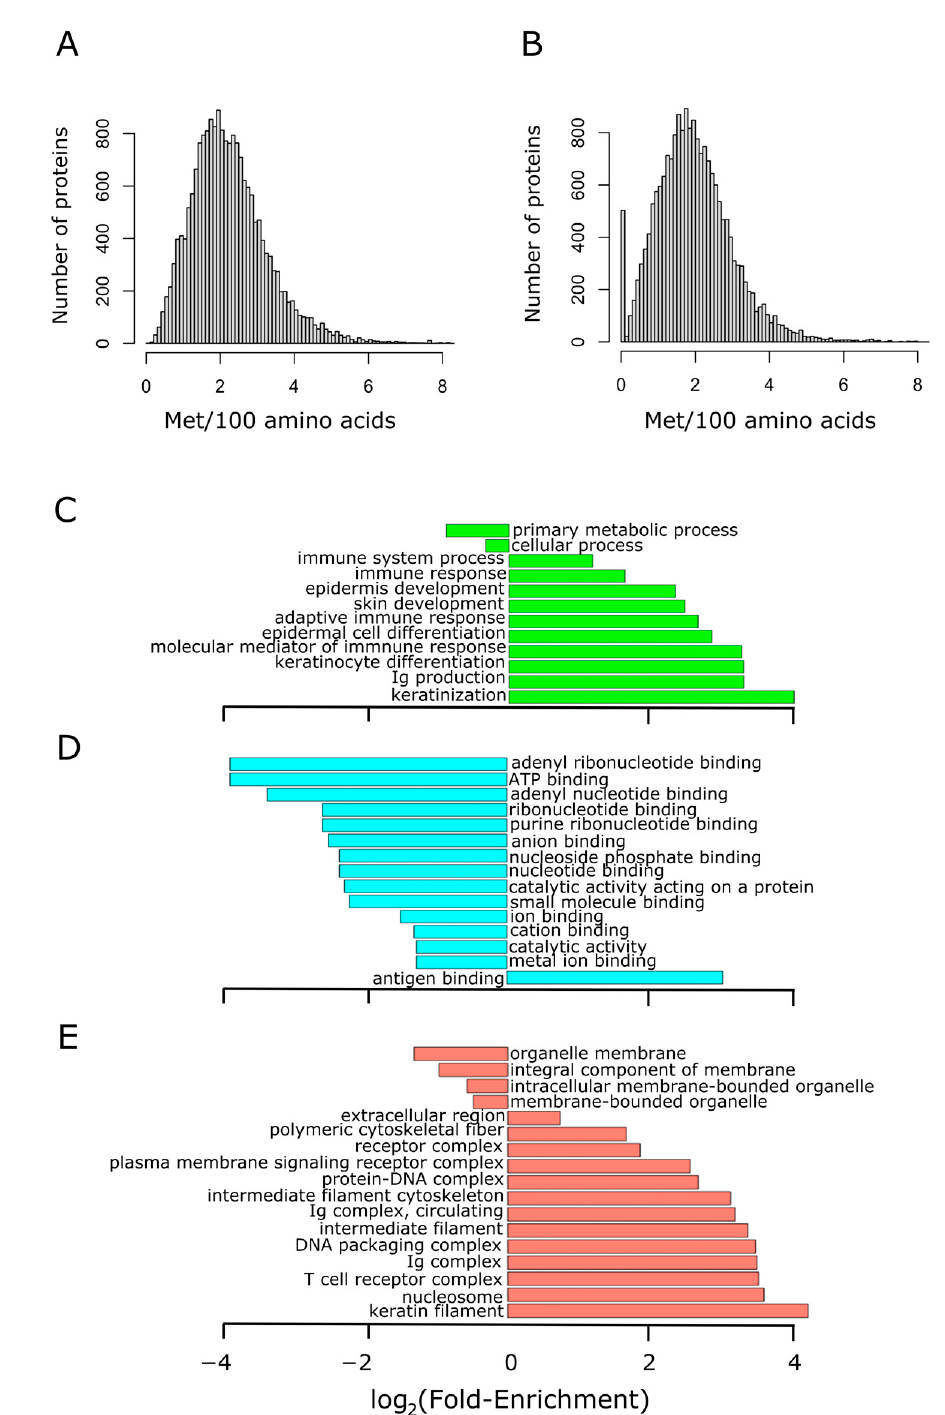
Figure 2. Proteins lacking methionine residues (other than the initiation methionine) are related to immunity. The methionine content distribution of the human proteome is shown in ( A ), where the median was found to be 2.1% (mean 2.2%). The methionine content was recomputed for the human proteome after removing the initiation methionine found at position 1. In this case, the median was located at 1.9% (mean 2%), and a group formed by 500 proteins stands out conspicuously in the distribution ( B ). This group of non-methionine-containing proteins was subjected to GO term enrichment analysis in the three ontologies separately: biological process ( C ), molecular function ( D ), and cellular component ( E ). The abscissa axis shows the binary logarithm of the fold-enrichment, computed as described in Section